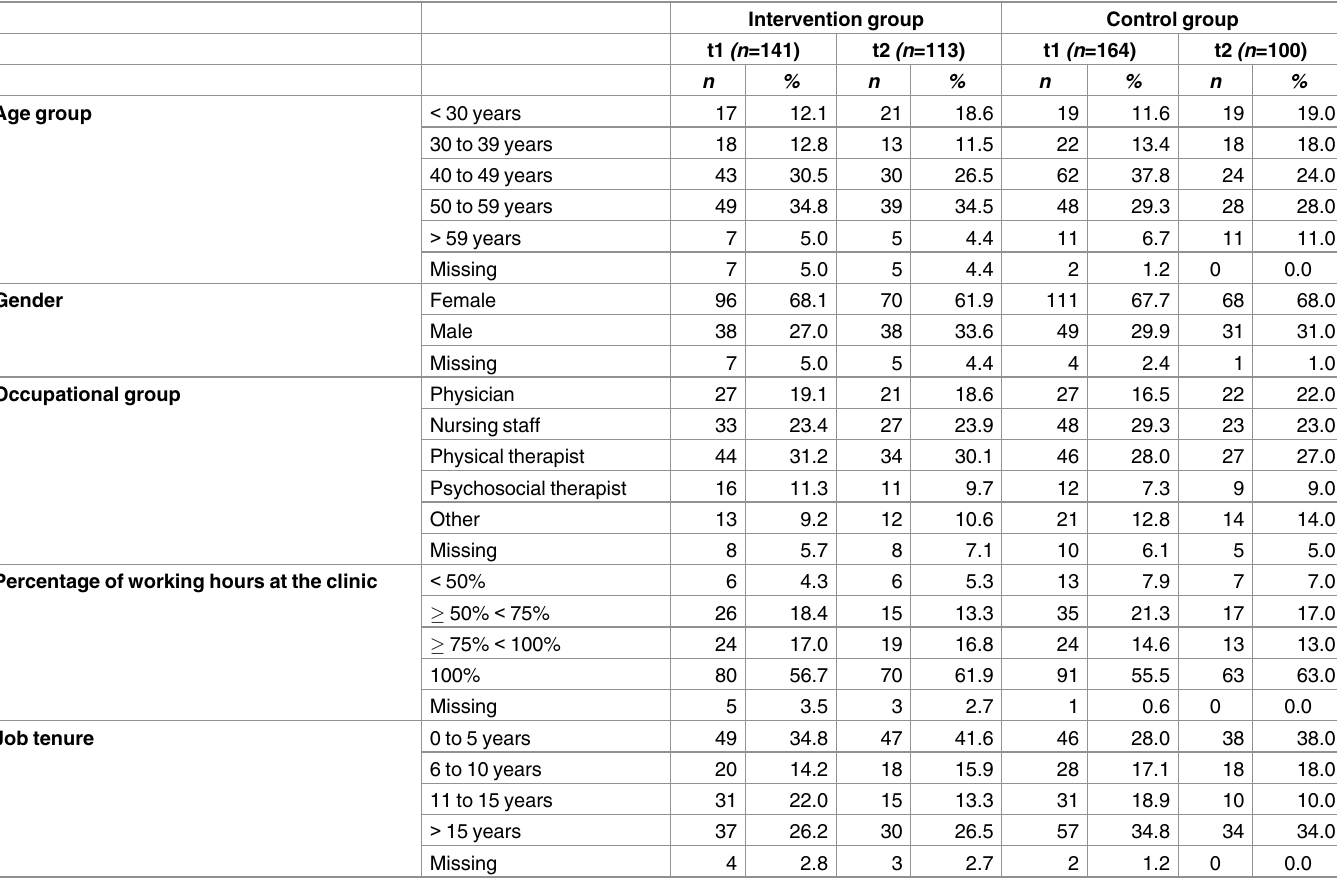
Table 2. Distribution of healthcare professionals for the pre- and post-intervention periods.